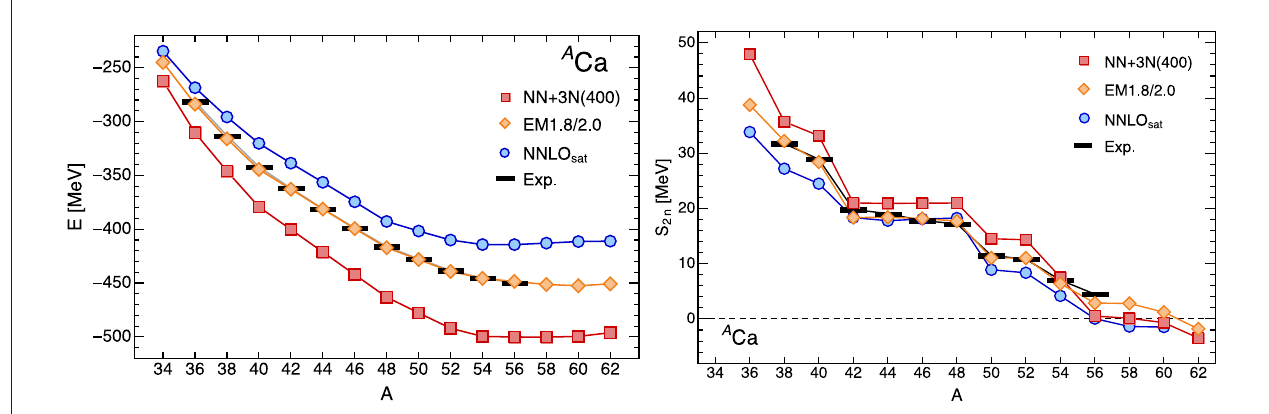
FIGURE 7 | Ground-state and two-neutron separation energies for several chiral NN+3N interactions from MR-IMSRG(2) calculations. Experimental data are indicated by black bars [184, 193].